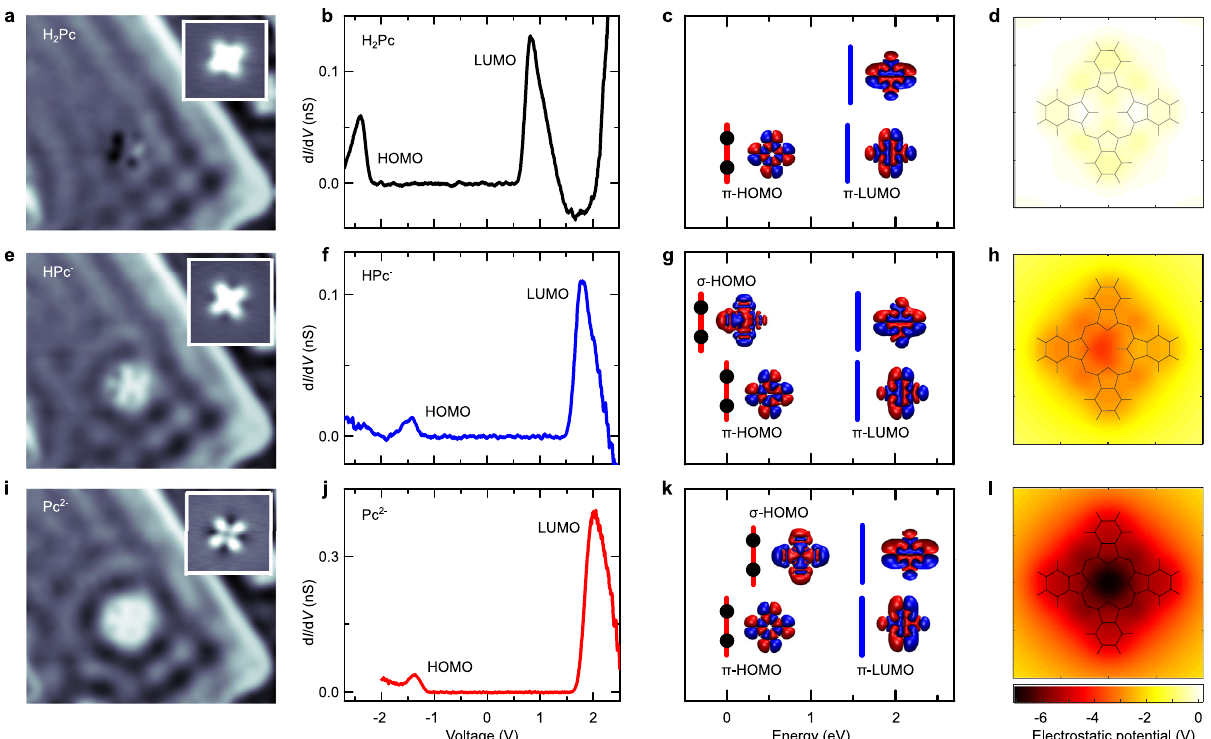
Fig. 2 Identifying charges con fi ned in deprotonated phthalocyanines. a , e , i Constant current d I /d V maps ( I = 30 pA, V = 400 mV, 12.5 × 10.8 nm 2 , modulation voltage δ V mod = 50 mV) recorded on ( a ) H 2 Pc, ( e ) HPc − , and ( i ) Pc 2 − . Images ( a ), ( e ), and ( i ) were acquired on a 2ML-NaCl island where the interface state scattering is stronger than on 3ML for a better visualization of the scattering. The conclusions regarding the charged character of the different species on 2 or 3ML NaCl remain however the same (see Supplementary Fig. 8). The insets show topographic STM images (3.7 × 3.7 nm 2 ) recorded simultaneously that reveal dark areas around HPc − and Pc 2 − , characteristic of charged molecules on NaCl 35 . b , f , j d I /d V spectra recorded on ( b ) H 2 Pc, ( f ) HPc − , and ( j ) Pc 2 − on 3ML of NaCl. c , g , k DFT calculations of the electronic structure of the frontier orbitals of ( c ) H 2 Pc, ( g ) HPc − , and ( k ) Pc 2 − together with their iso-surface representations and their electronic occupation. d , h , l calculated images of the electrostatic fi eld for ( d ) H 2 Pc, ( h ) HPc − , and ( l ) Pc 2 − . The potential is displayed 0.21 nm above the plane of the molecule. The NaCl layer is not included in the calculation. Source data are provided as a Source Data fi